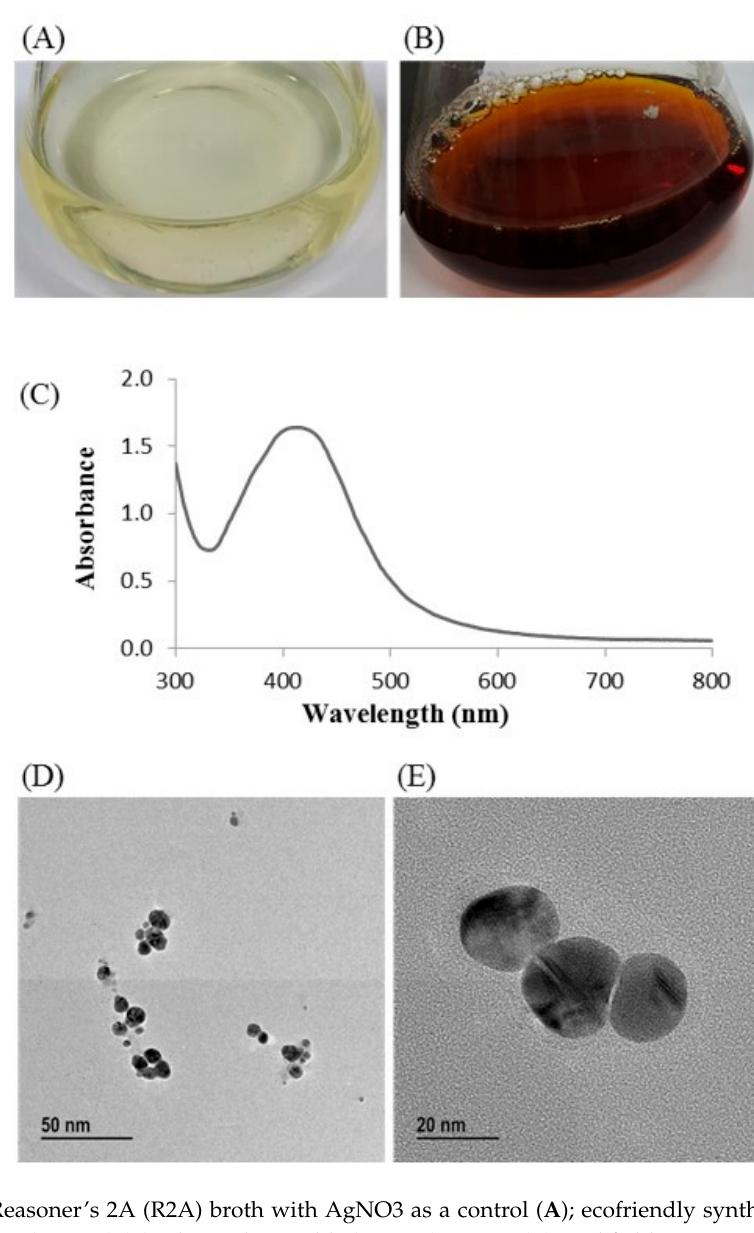
Figure 3. Reasoner’s 2A (R2A) broth with AgNO3 as a control ( A ); ecofriendly synthesized silver nanoparticles (AgNPs) ( B ); ultraviolet–visible (UV–vis) spectra ( C ); and field emission-transmission electron microscopy (FE-TEM) images of ecofriendly synthesized silver nanoparticles ( D , E ).